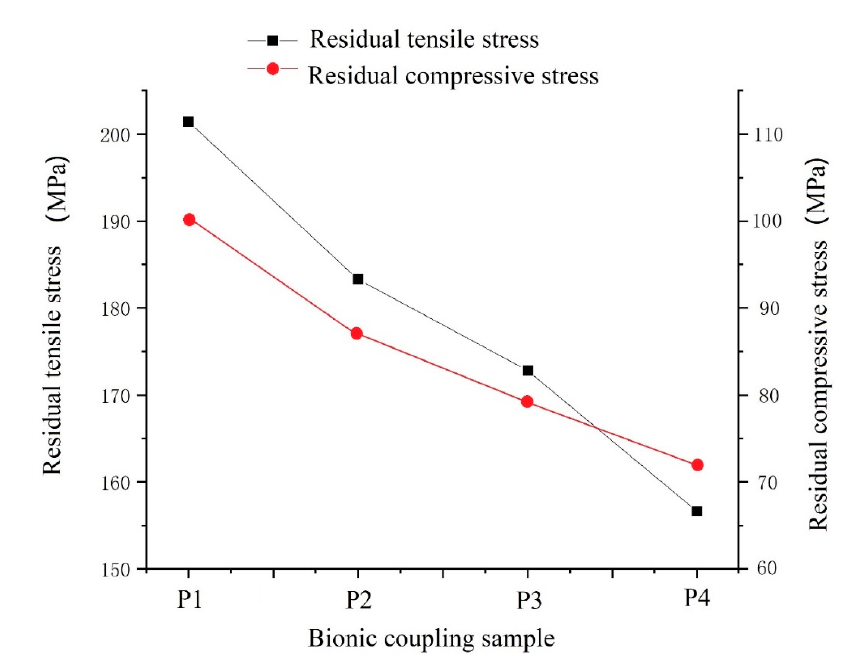
Figure 13. Surface stress values of elements in four models of different distance distribution.